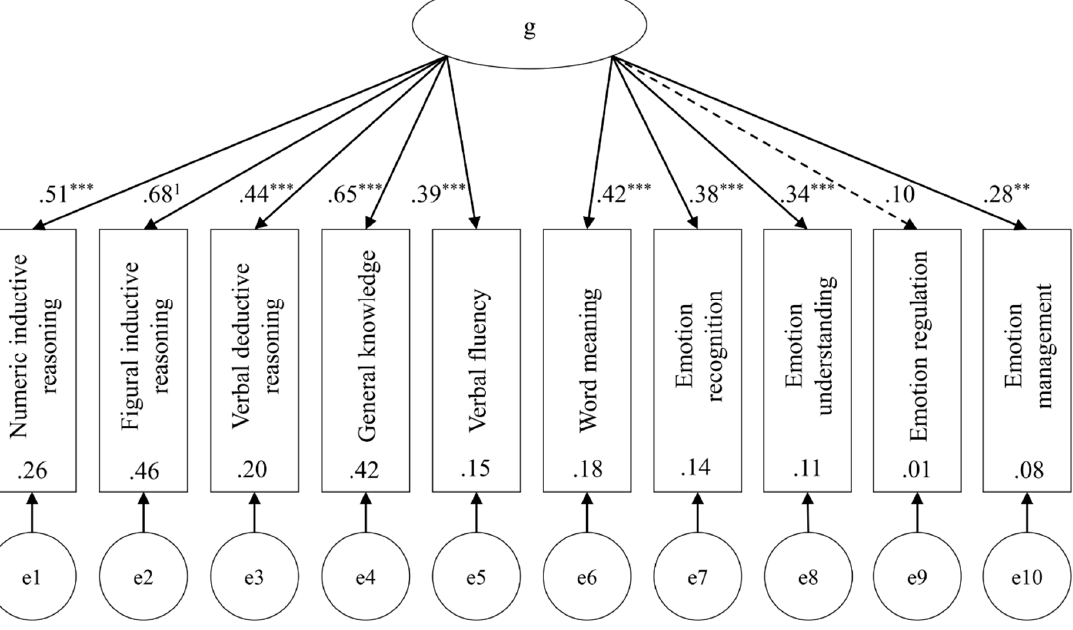
Figure 1. Unidimensional model (Model 1).